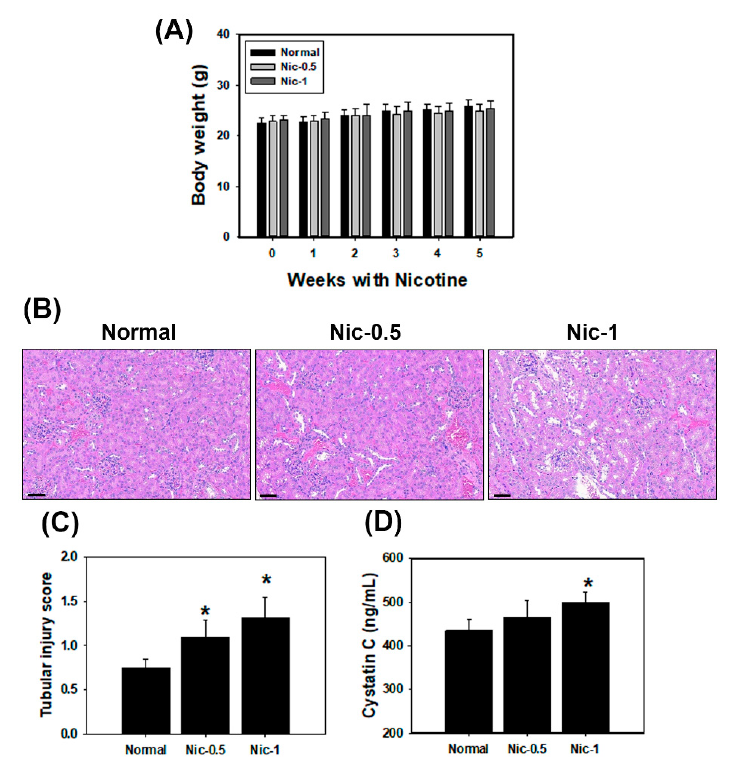
Figure 6. Nicotine increased tubular injury in mouse kidney tissues. Mice were administered with 0.5 and 1 mg / kg nicotine three times per week for 4 weeks. ( A ) Measurement of body weights of C57BL / 6 miceinvariousgroups. Dataarepresentedasthemeans ± standarddeviation. ( B )Representativeimages of kidney sections in mice were stained with H&E and examined by microscopy. Scale bar = 60 µ m. ( C ) The tubular injury score was quantified in kidney sections (5 mice per group). ( D ) The levels of Cys C in the mice serum (5 mice per group) were measured by ELISA. * p < 0.05 versus normal group. Data are presented as the means ± standard deviation. Statistical significance was estimated with ANOVA by Dunnett’s multiple comparison